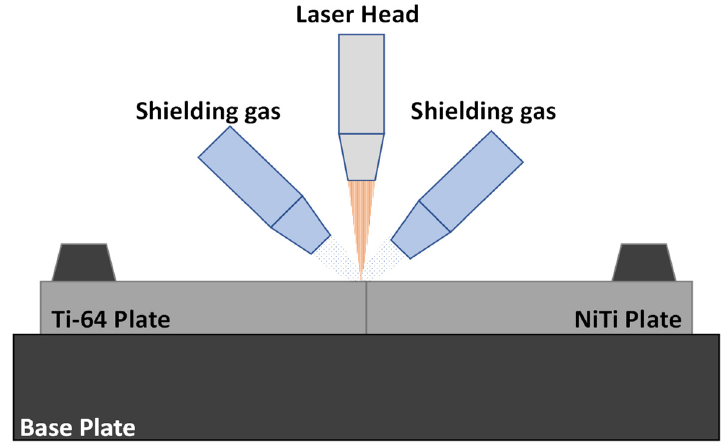
Figure 1. Diagram illustrating the process of LW of dissimilar components.